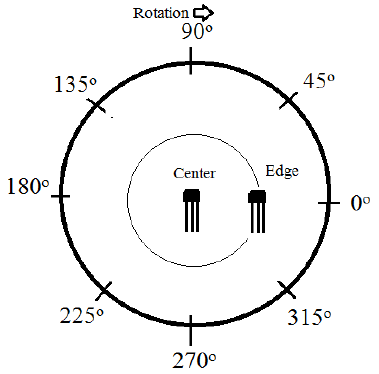
Figure 1. The measures were performed at the center of the samples and 6 mm from this point and according to the indicated angles.